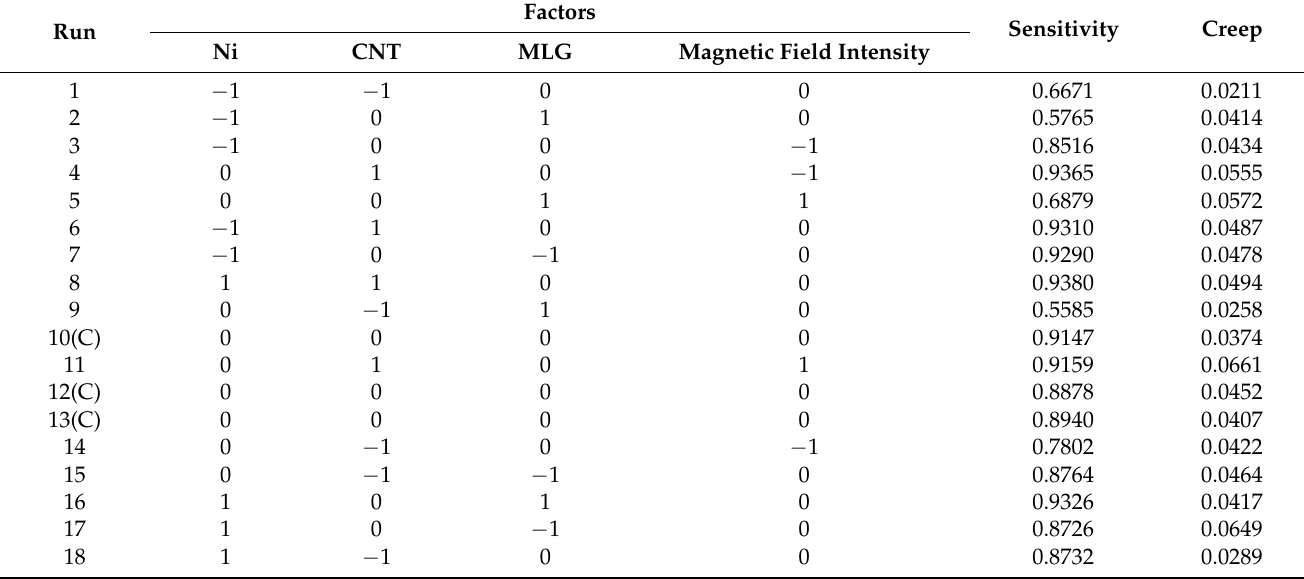
Table 3. Box–Behnken design (BBD) and experimental